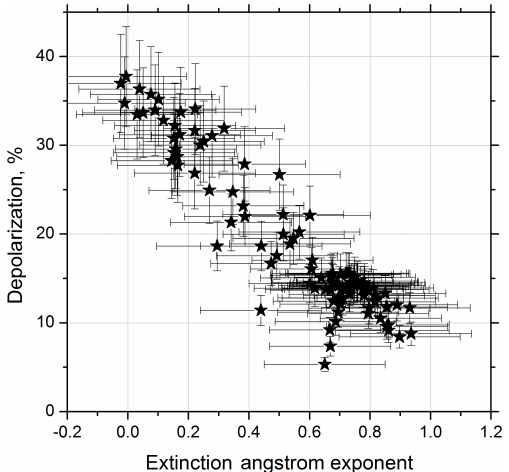
Figure 9. Lidar ratios at 355nm (solid lines) and 532nm (dash lines) for three temporal intervals from Fig. 7.